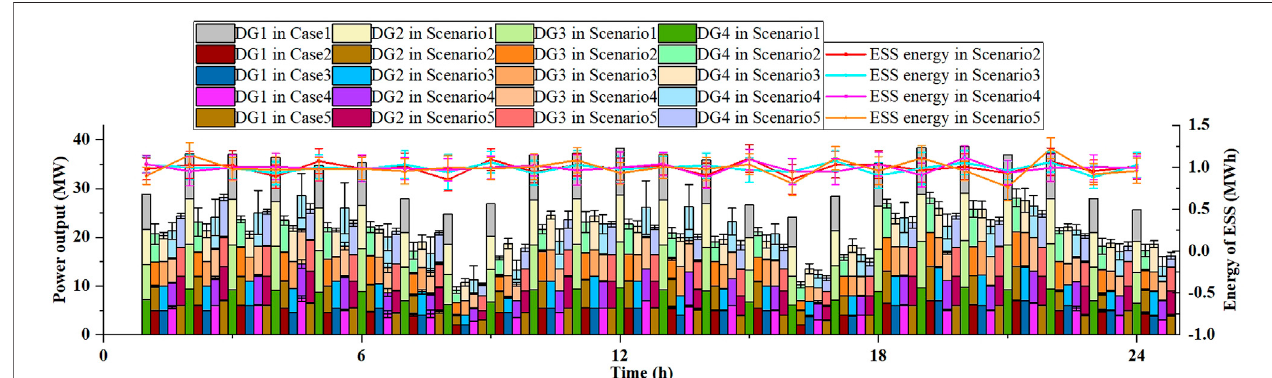
FIGURE 7 | Hourly optimized outputs of DGs and on-board ESS under various